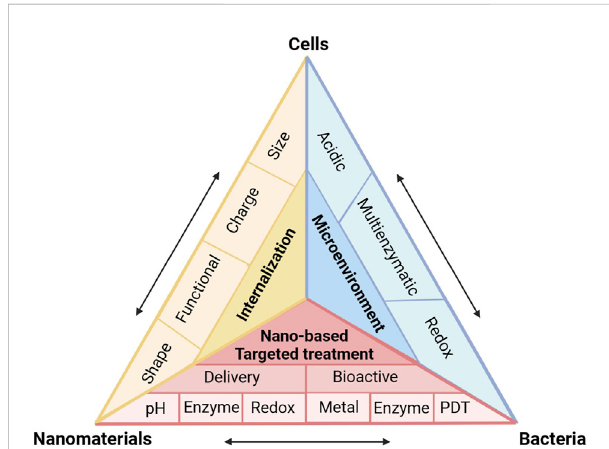
FIGURE 1 Schematic of interactions between cells, intracellular bacteria and nanomaterials during employing multifunctional nanomaterials against intracellular infections.